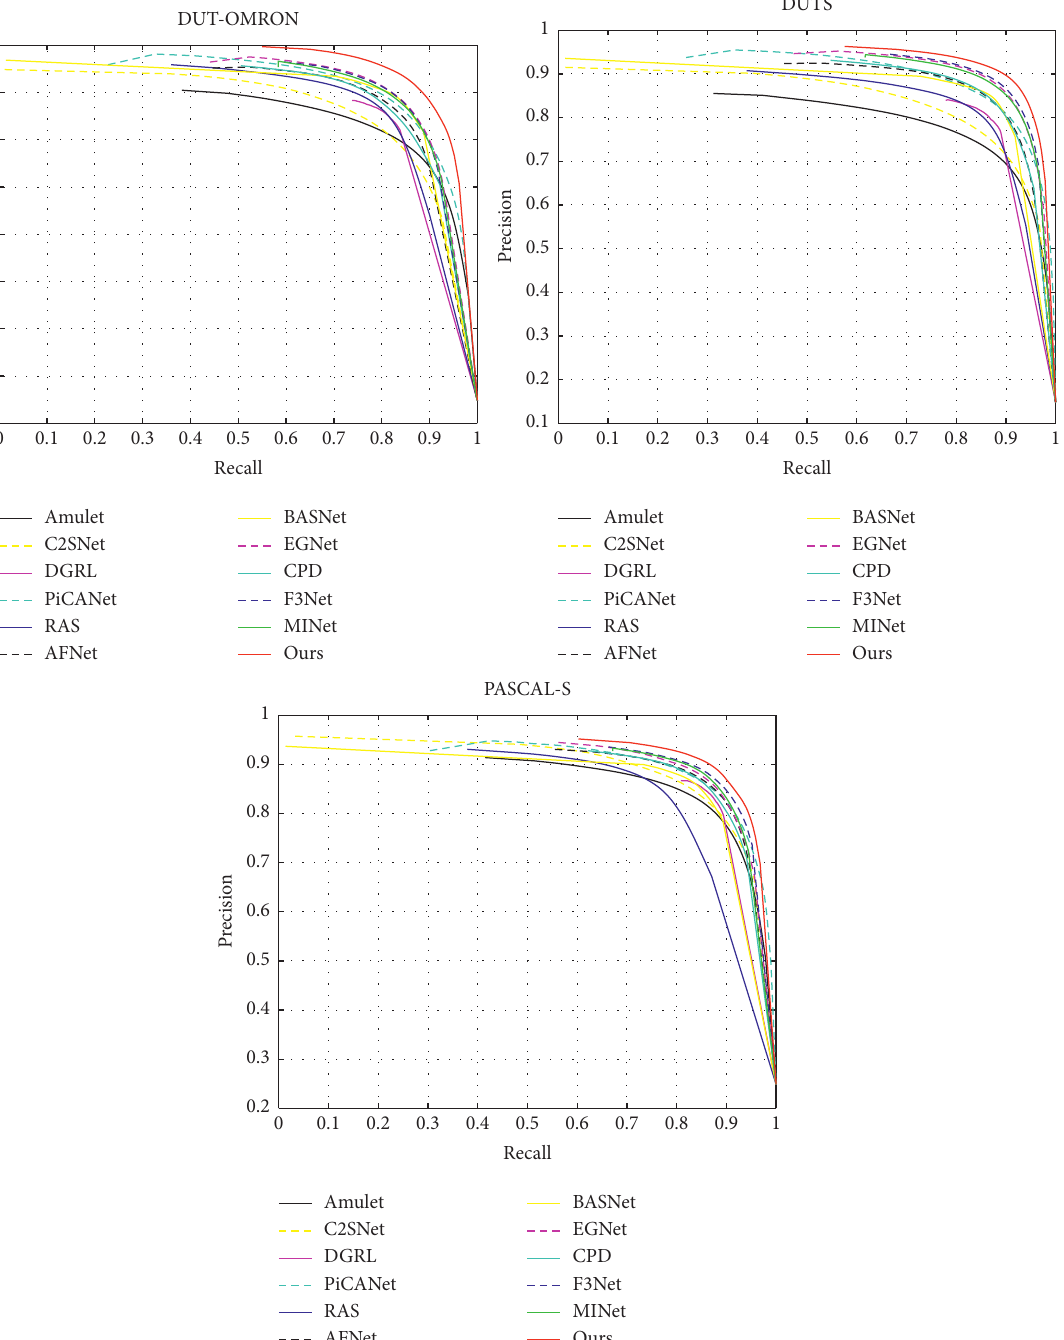
Figure 7: Precision-Recall curves on three saliency datasets, including DUT-OMRON, DUTS, and